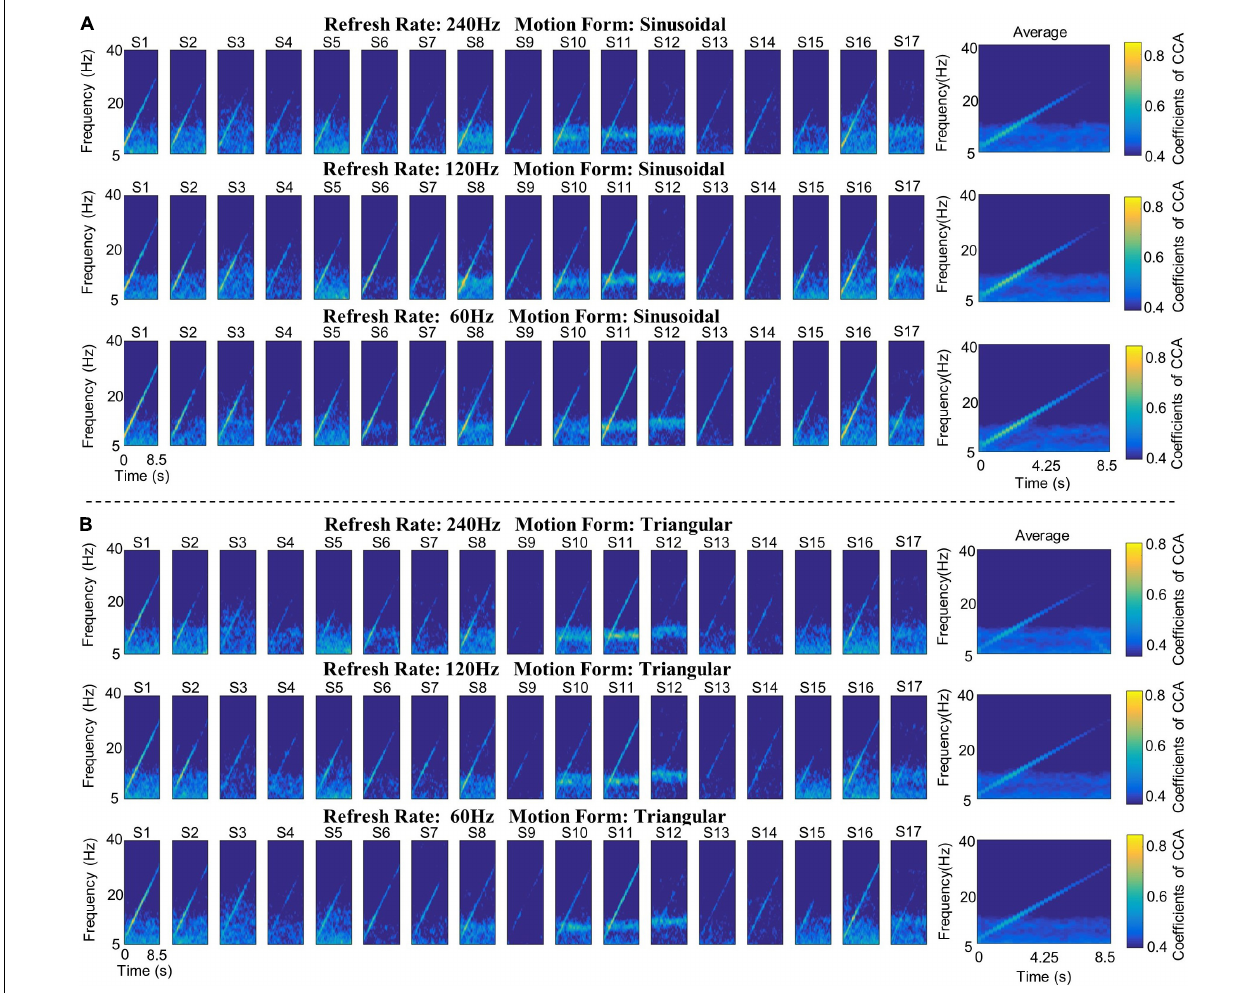
FIGURE 3 | The CCA coefficient spectrum of the Sweep-SSMVEP paradigm. (A) The sinusoidal motion stimulation response. (B) The triangular motion stimulation response. Each row represents the stimulus response at the same refresh rate, each column (column 1–17) represents the stimulus response of the same participant, and the last column represents the average response of all participants under different refresh rates. In the CCA coefficient spectrum, the vertical axis indicates the response frequency, the horizontal axis indicates the stimulation duration, and the color indicates the value of the CCA